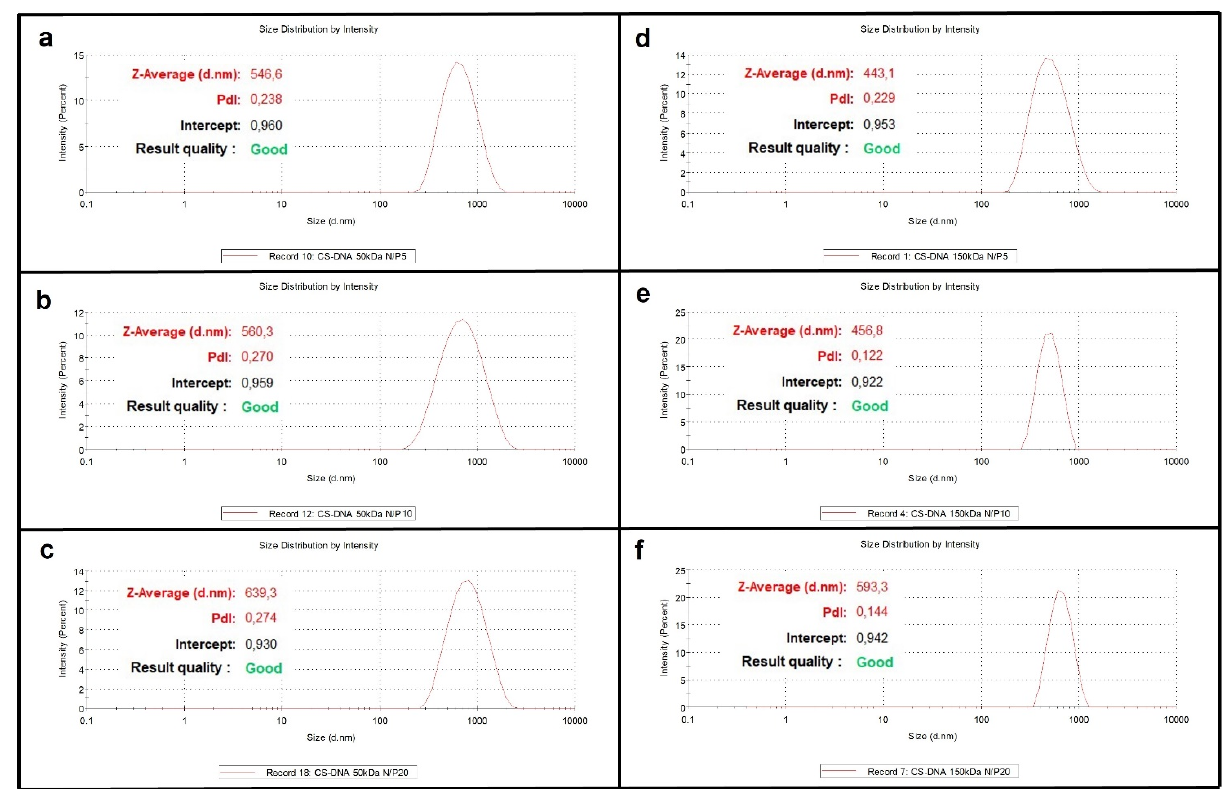
Figure 1. Size distribution by intensity of CS/hsDNA complexes prepared with CS of different mo- lecular weights and at different N/P values (from N/P 5 to N/P20 by using 50 and 150KDa chitosan). Table 3. Hydrodynamic diameter (nm) of CS/hsDNA complexes prepared with CS of different mo- lecular weights and at different N/P values.